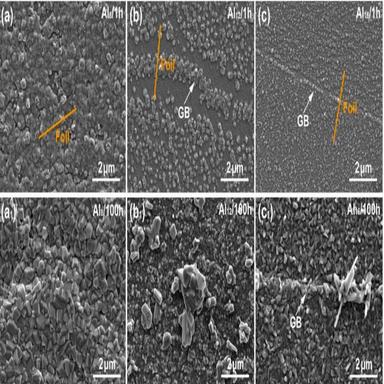
The SEM characterizations of oxide scale of the Fe71.5-x(Ni, Cr, Ti)28.5Alx CCAs after 1 h and 100 h oxidations at 800 ◦C in air: (a, a1) Al8 CCA, (b, b1) Al12 CCA, (c, c1) Al16 CCA.